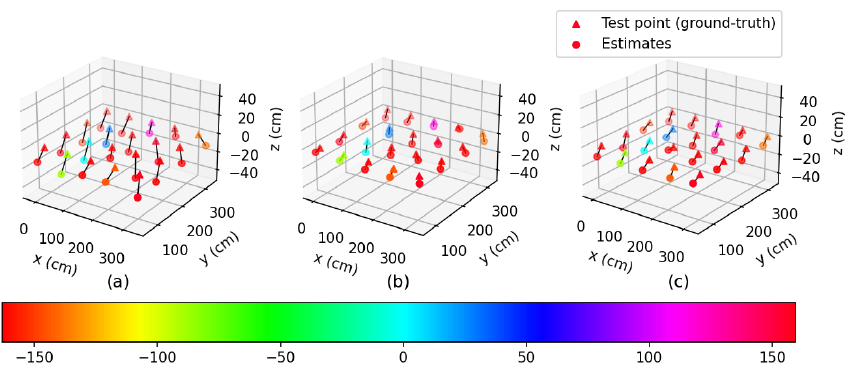
Figure 4. Estimated positions of the mobile node for the three ranging schemes: ( a ) AltDS-TWR (w/o Antenna Delay), ( b ) AltDS-TWR (w/Antenna Delay), and ( c )